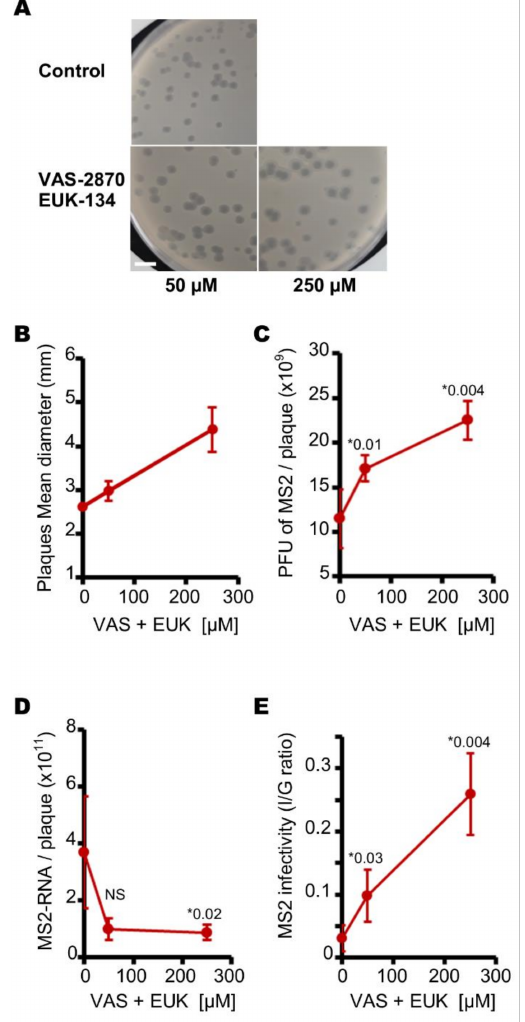
Figure 6. VAS-2870 and EUK-134 increase the size of MS2 plaques and the infectivity of MS2 phages when cultured under aerobic conditions with E. coli . ( A ) pictures of plaques of MS2 phages cultured on a lawn of E. coli under aerobic conditions with or without VAS-2870 and EUK-134, at concentrations of 50 or 250 µ M (white scale bar corresponds to 1.0 cm). ( B ) the presence of VAS-2870 and EUK-134 in concentrations of 0 and 250 µ M increases the size of MS2 plaques when cultured on a lawn of E. coli under aerobic conditions. ( C ) curve showing the evolution of the amount of infectious MS2 phages in 3 mm plaques depending on the concentration of VAS-2870 and EUK-134. ( D ) curve showing the change in number of MS2 genome copies in 3 mm plaques depending on the concentration of VAS-2870 and EUK-134. E, VAS-2870 and EUK-134 at concentrations of 0 and 250 µ M increase the infectivity of MS2 phages (I/G ratio) in 3 mm plaques cultured under aerobic conditions. Each data point is an average of several replicates ( n = 7 for panels A to E) obtained on four separate days. Error bars indicate standard errors. “*” stands for “p value” determined as described in the Materials and Methods section. “NS” stands for statistically non-significant: p >